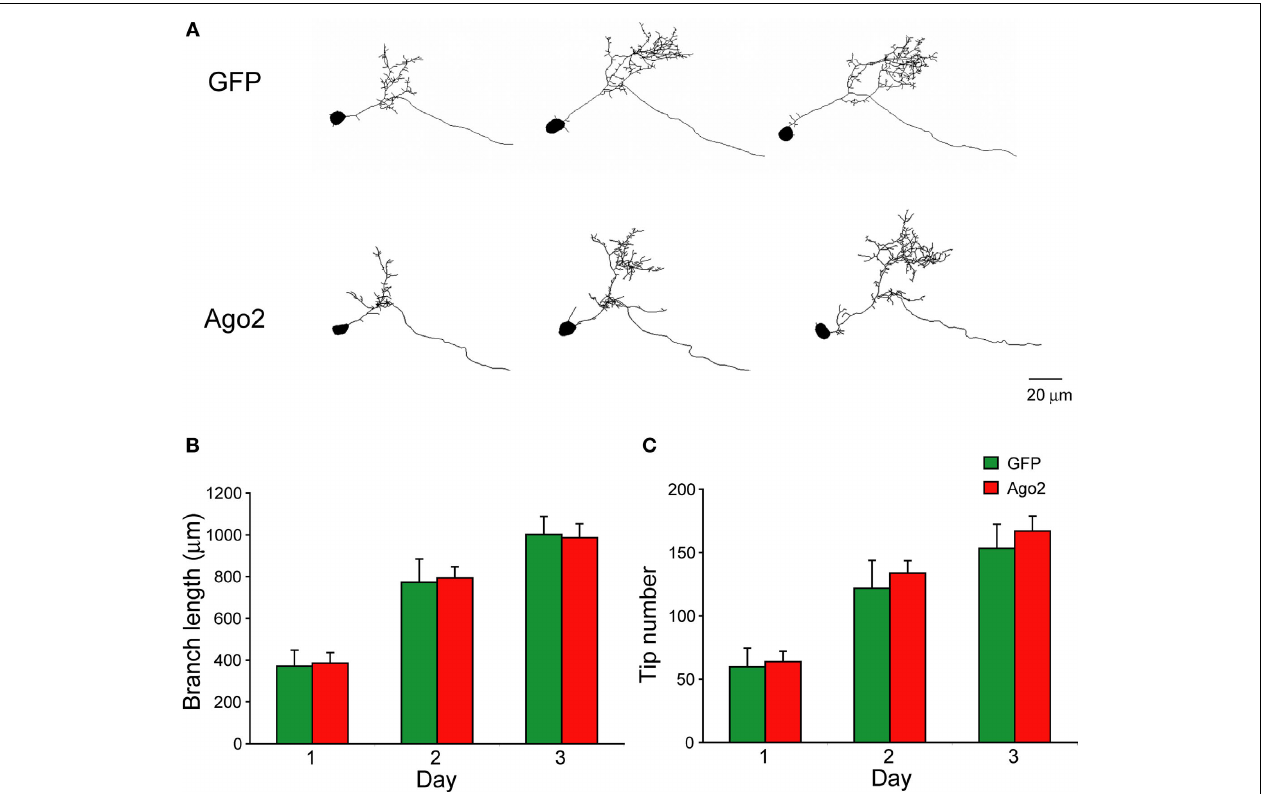
FIGURE 5 | Neurons expressing ectopic Ago2 acquire normal dendritic arbor structure. Individual optic tectal neurons expressing GFP or GFP + Ago2 were imaged daily over 3 days in living animals (A) . Total dendritic branch length